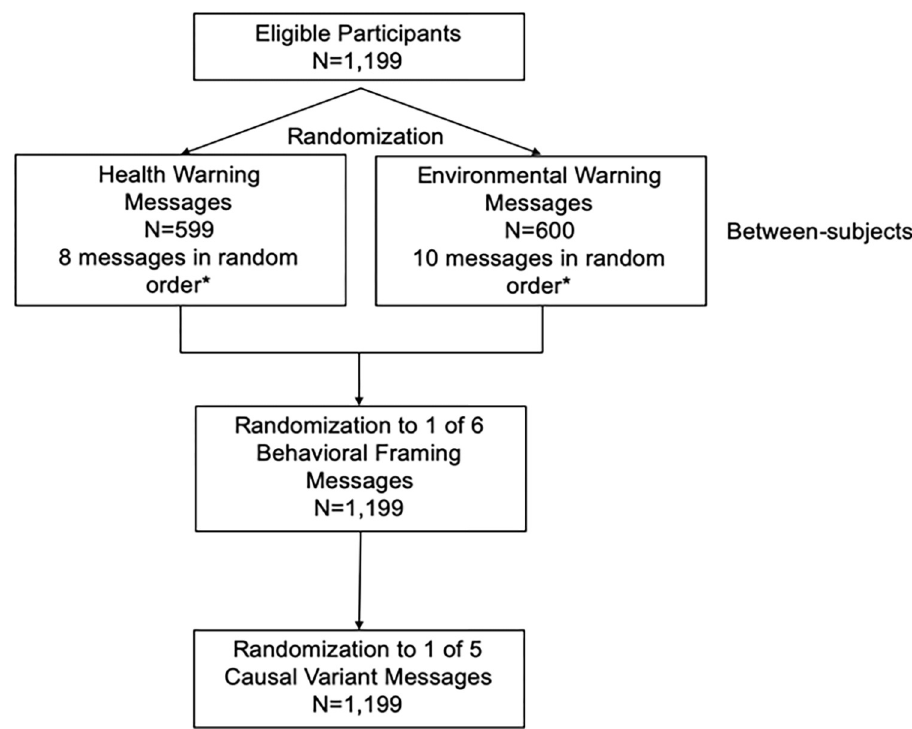
Fig 2. Participant flow diagram of online experiment of 1,199 U.S. adults (March 2020). � Within-subjects factor was the 8 health and 10 environmental